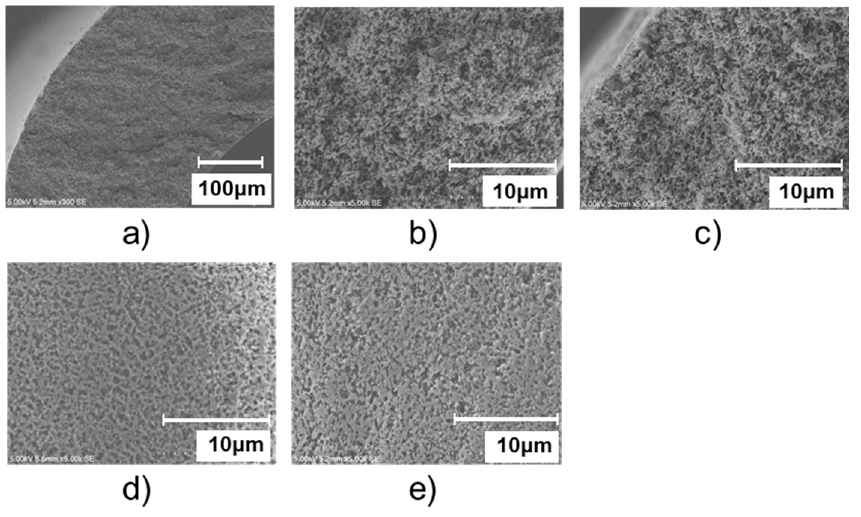
Figure 6. Membrane morphology. ( a ) Cross section, ( b ) Near the bore side of the cross section, ( c ) Near the shell side of the cross section, ( d ) Bore surface, ( e ) Shell surface. Table 1. Membrane properties.